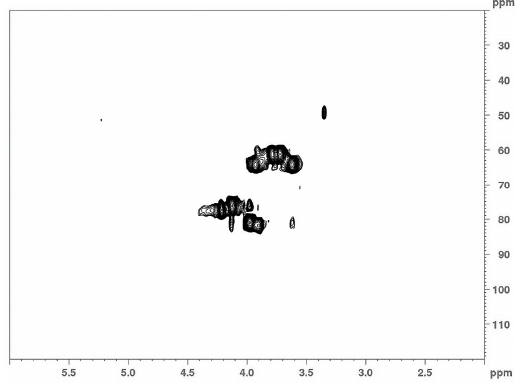
Figure 4. 2D-NMR analysis of the Lev_2ASCA polymer: The HSQC spectrum was recorded with a 600 MHz Bruker spectrometer.